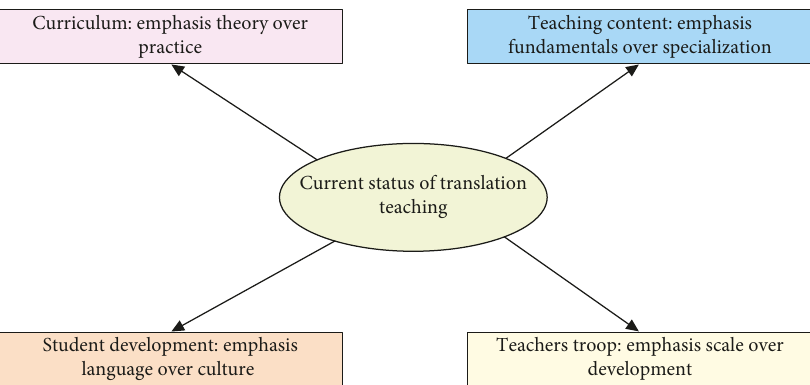
Figure 1: The current status of teaching translation in English